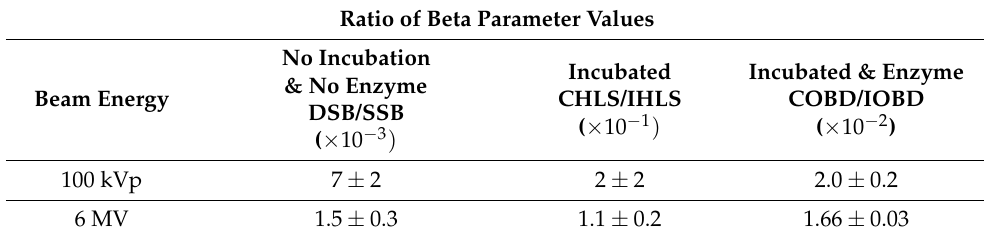
Table 4. Summary of the ratios of DSB/SSB, CHLS/IHLS, and COBD/IOBD. Ratio of Beta Parameter Values